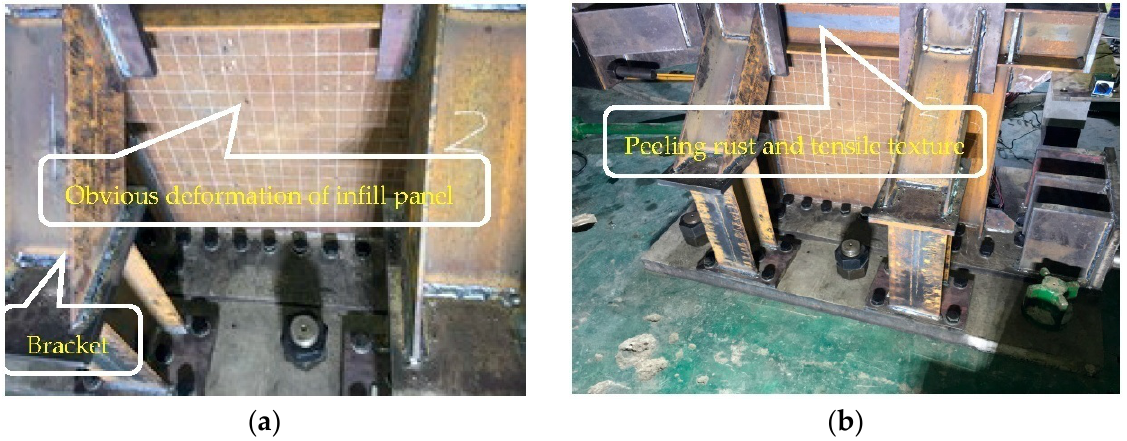
Figure 15. Deformation of the infill panel and top beam for specimen 1: ( a ) Infill panel; ( b ) Top beam. At the thirteenth loading level, the maximum forward force of the actuator was 370.2 kN whose displacement was 10.5 mm, whereas reverse loading was 765.5 kN and displacement was 11.4 mm. The flanges of the column foot on both sides were in the yielding state and a continuous sharp brittle sound was observed during the loading procedure. The forward loading displacement was up to 16.9 mm and the overall bearing capacity of the structure obviously degraded, which was caused by the further expansion of the deformation for the infill panel and the bulging of the upper flange for the top beam at one end of the loading head. Meanwhile, the steel plate connected with the loading head deformed in buckling as a result of the thin plate thickness. By now the maximum out-of-plane displacement of the infill panel reached 25.7 mm and the deformation of different members was indicated in Figure 16, respectively.